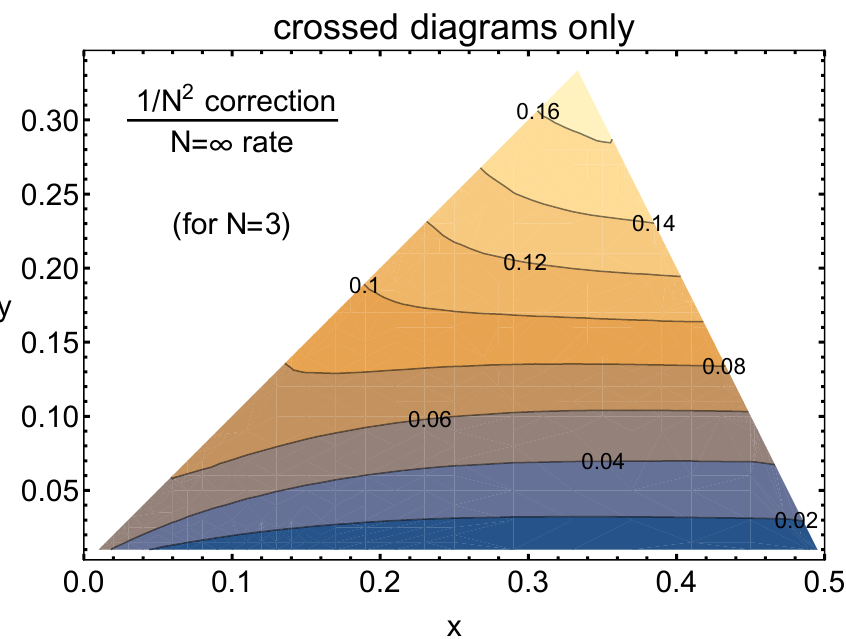
Figure 15 . The ratio, for crossed diagrams only, of (i) the 1 /N 2 correction to (ii) the N = ∞ result for the differential rate d Γ /dx dy for (the crossed diagram contribution to) overlapping double splitting g → ggg . We have used N = 3 in this plot, but one may multiply the results by (3 /N ) 2 to restore the N dependence of the 1 /N 2 correction. Very tiny wiggles in the contour lines are an artifact of interpolation from a discrete set of numerical data points. We have left out y < 0 . 01 just to simplify the numerical effort that went into making this plot. The ratio goes to zero as y → 0 , as one may see from the later discussion of figure 19 for a particular value of x